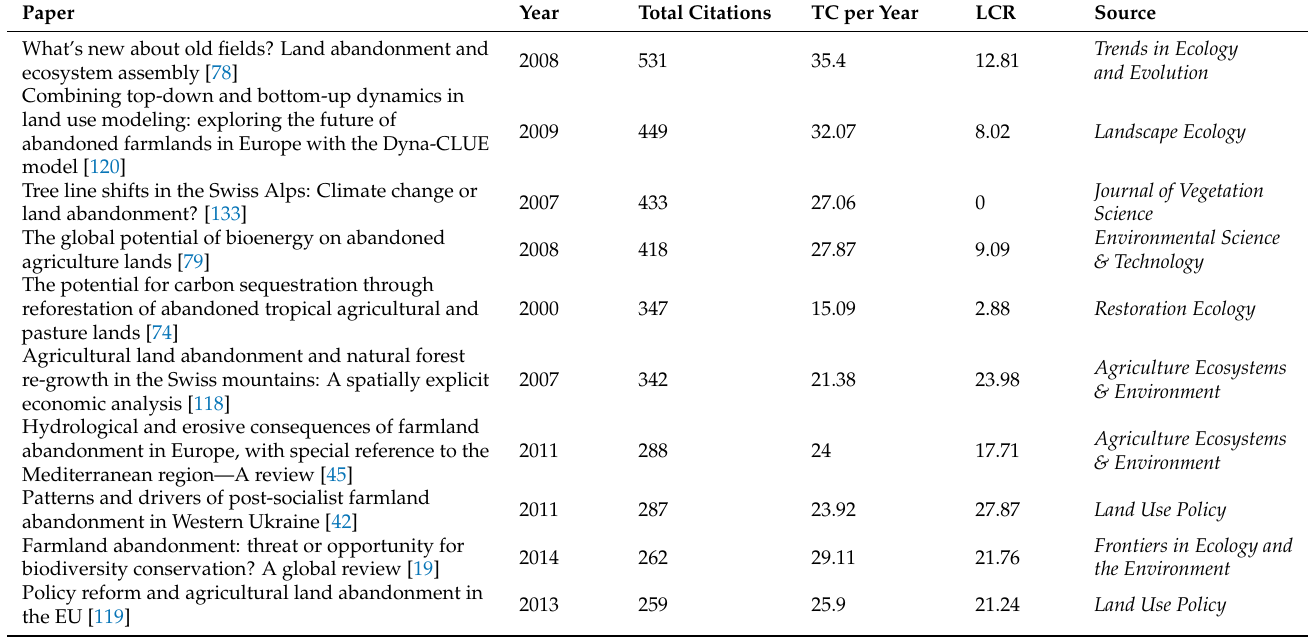
Table 4. Highly cited articles on farmland abandonment from 1980 to 2021 (Note: TC per Year = total citations per year; LCR = local citation